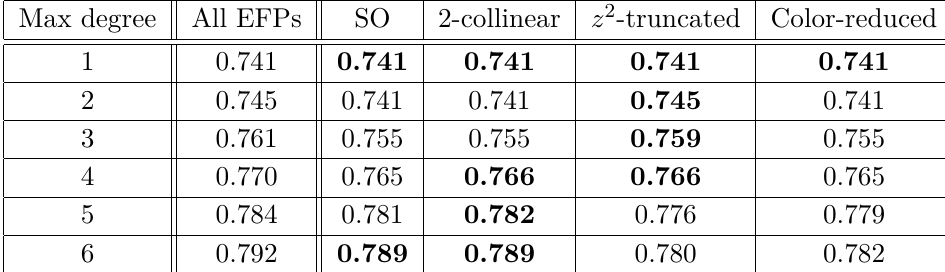
Table 6. AUCs for the ROC curves displayed in figure 11. The uncertainty for all AUC values is ± 0 . 003 , obtained from the 95% confidence interval coming from 10-fold cross validation. Bold-faced entries show the best performing approximations in each row.